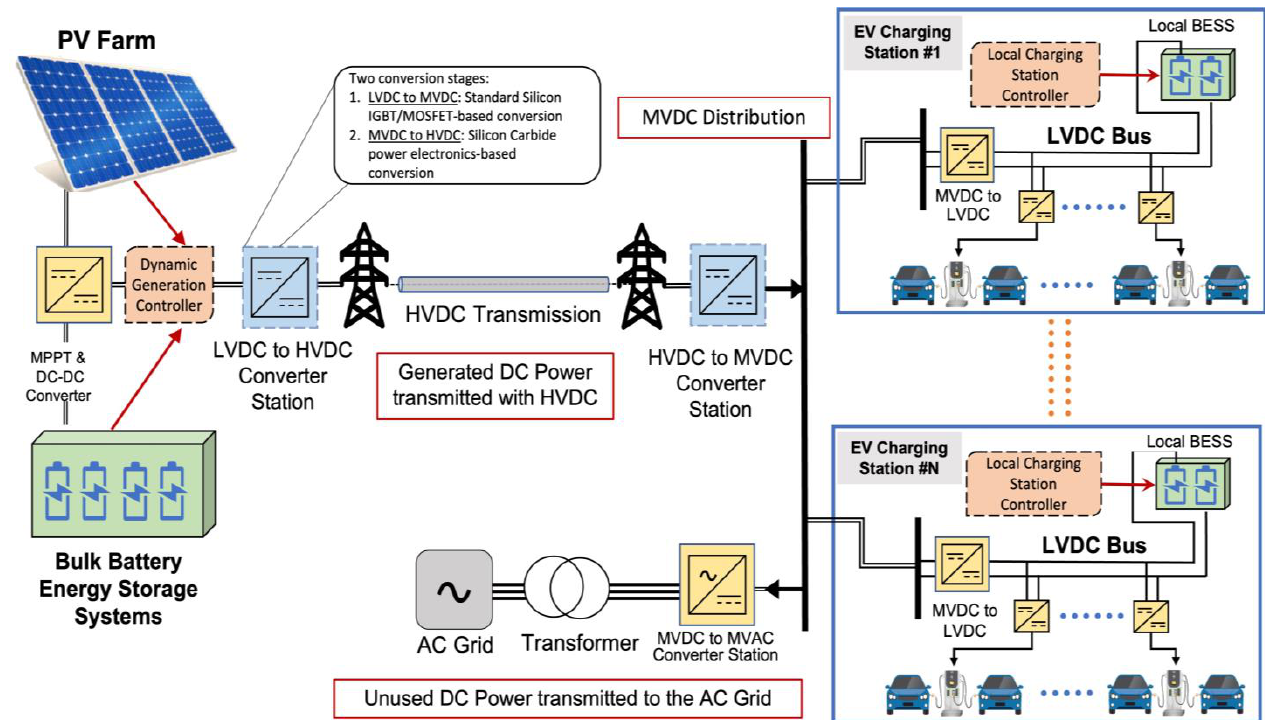
Figure 3. Proposed end-to-end DC fast charging EV